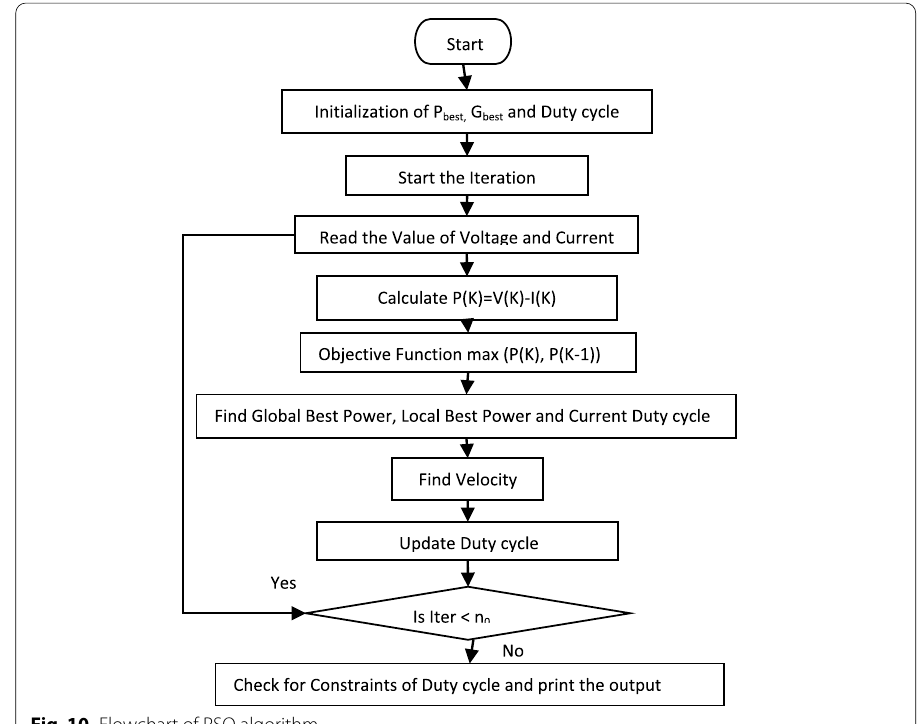
Fig. 10 Flowchart of PSO